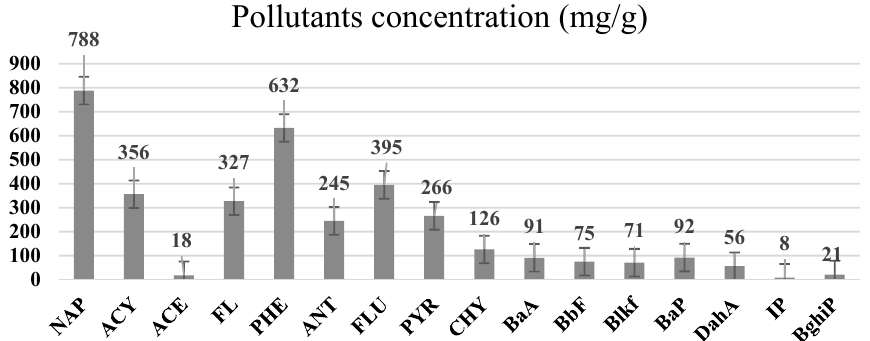
Figure 3. The concentration of PAHs in the coal tar sample, as found in the present study.